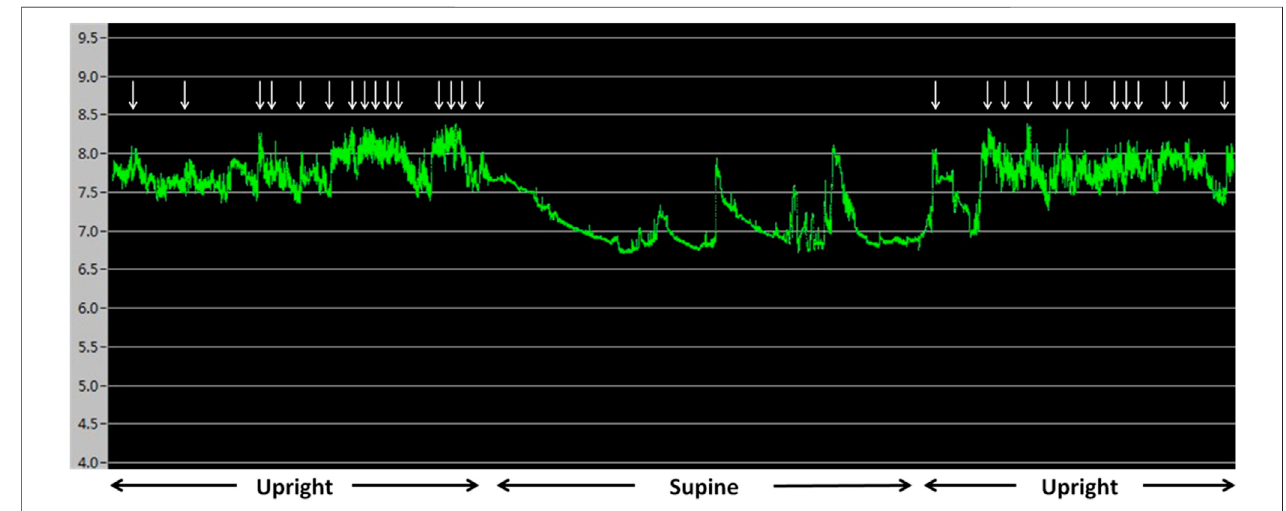
FIGURE 3 | Results of 24 h pharyngeal pH monitoring of a patient with IPF The upright and supine periods can be identi fi ed easily by the pattern of the pH recording. pH was more than 7.5 for the majority of the monitoring time. ↓ represent cough events. Cough occurred when pH was > 7.5.